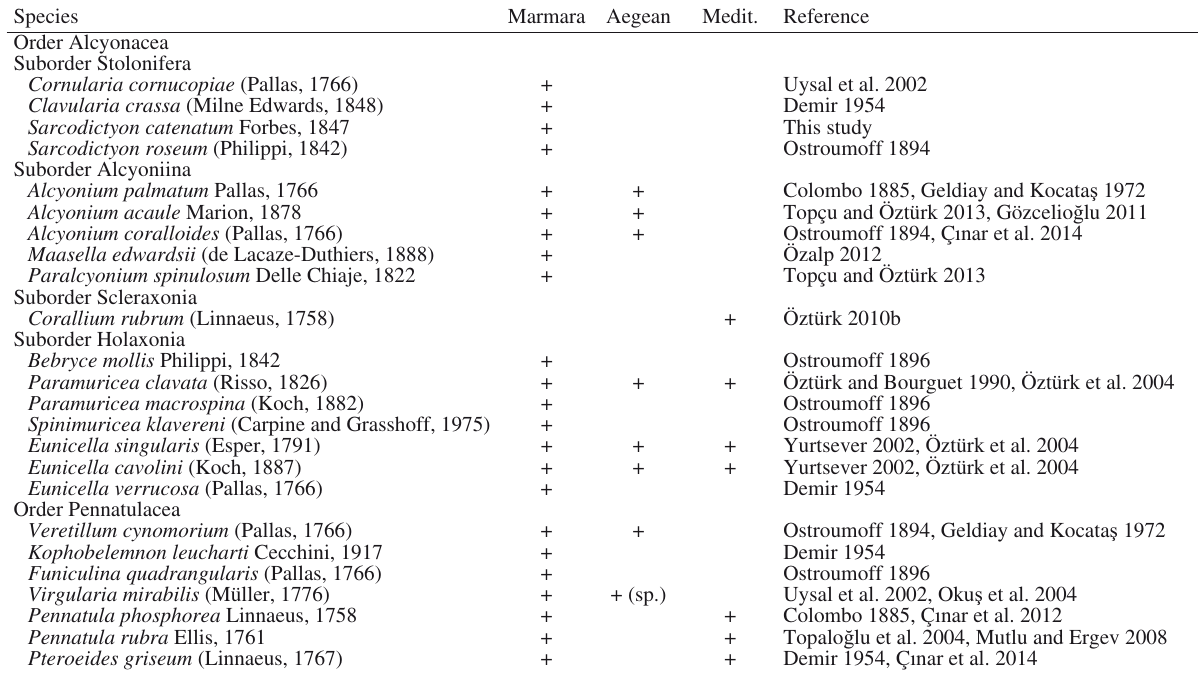
Table 5. – Check-list of octocoral species for the Turkish coasts (Sea of Marmara, Aegean and Mediterranean (Medit.) coasts of Turkey).